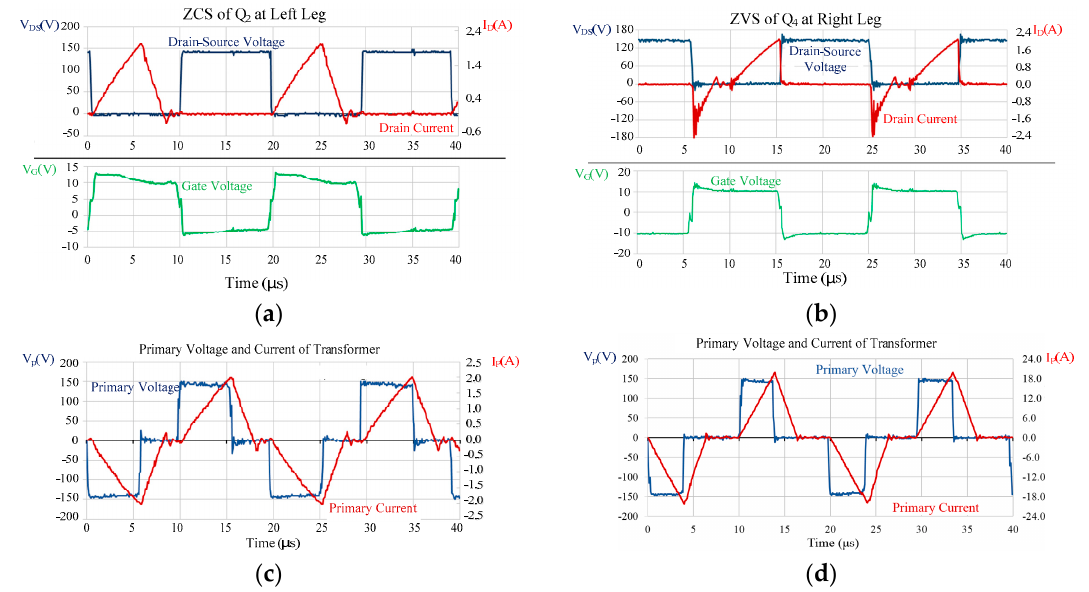
Figure 10. Switching Performance of Improved Converter: ( a ) Q 2 Switching under Zero Current Condition; ( b ) Q 4 Switching under Zero Voltage Condition; ( c ) Transformer Primary Voltage and Current at Light Load; ( d ) Transformer Primary Voltage and Current at Full Load.